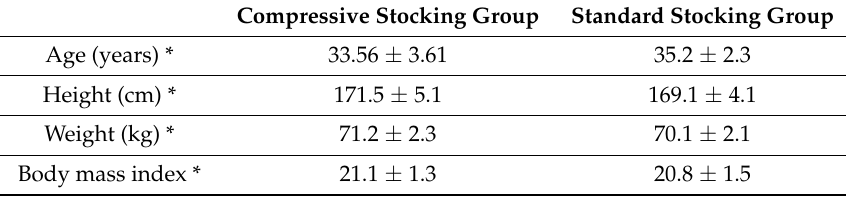
Table 1. Participant characteristics ( n = 49 compressive stocking and 49 standard stocking